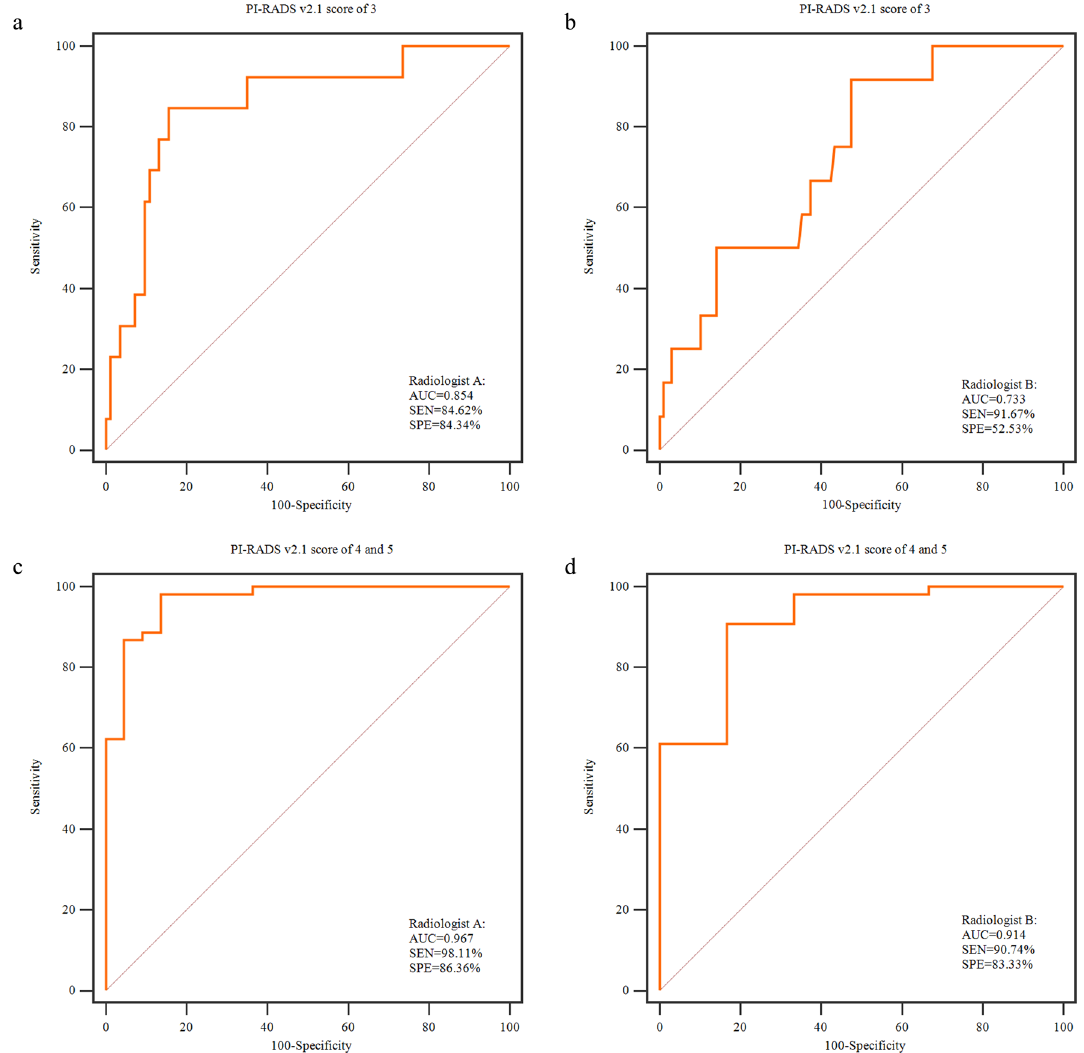
Figure 4. Verify the performance of radiomics model in lesions with PI-RADS v2.1 score of 3 ( a , b ) and PI-RADS v2.1 score of 4–5 ( c , d ) by junior Radiologist A ( a , c ) and senior Radiologist B ( b , d ) using receiver operating characteristic curves. Radiologist A, PI-RADS v2.1 score by a junior radiologist; Radiologist B, PI-RADS v2.1 score by a senior radiologist; SEN sensitivity, SPE